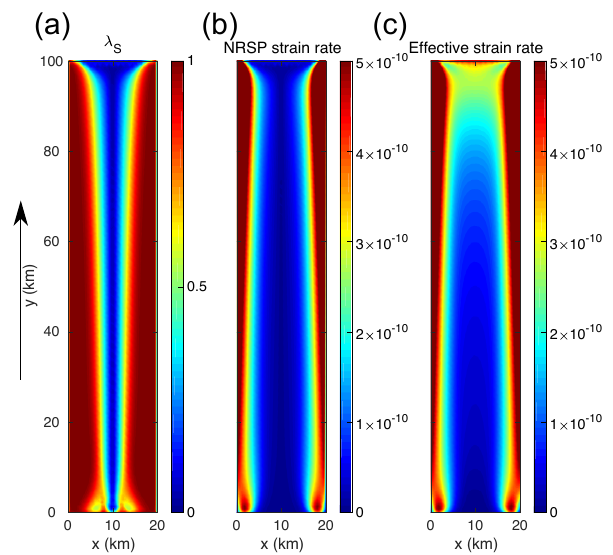
Figure 5. Rectangular ice shelf ESTAR higher-order steady-state surface fields. (a) ESTAR shear ratio λ S ; (b) shear strain rate re- solved on the non-rotating shear plane (NRSP) ˙ ε (cid:48) (s − 1 ); and (c) ef- fective strain rate ˙ ε e (s − 1 ). The black arrow indicates the direction of flow. Table 1. Computation times for simulations of the higher-order em- bayed ice shelf model (Sect. 6.1) using Glen and ESTAR flow rela- tions. The model is simulated for 1000 years with 2 year time steps, and for a mesh of 80080 vertices over 10 vertical